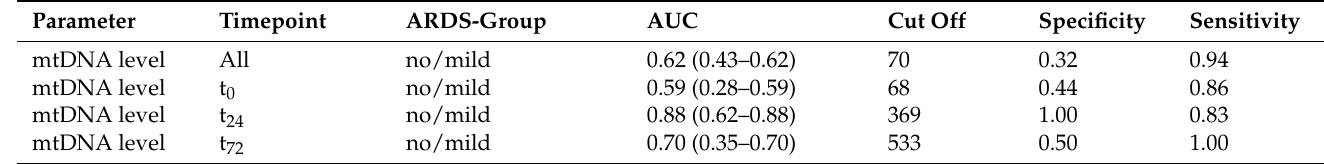
Figure 5. Prediction of in-hospital mortality in ARDS subgroups. The receiver operating characteristic curves are shown for the mtDNA levels, divided into ARDS-groups (no/mild and moderate/severe). The curves are presented for each time point (t 0 , t 24 and t 72 ) individually, as well as for all timepoints. Abbreviations: ARDS = acute respiratory distress syndrome. Table 3. AUC with 95% confidence interval for the prediction of in-hospital mortality in ARDS subgroups.